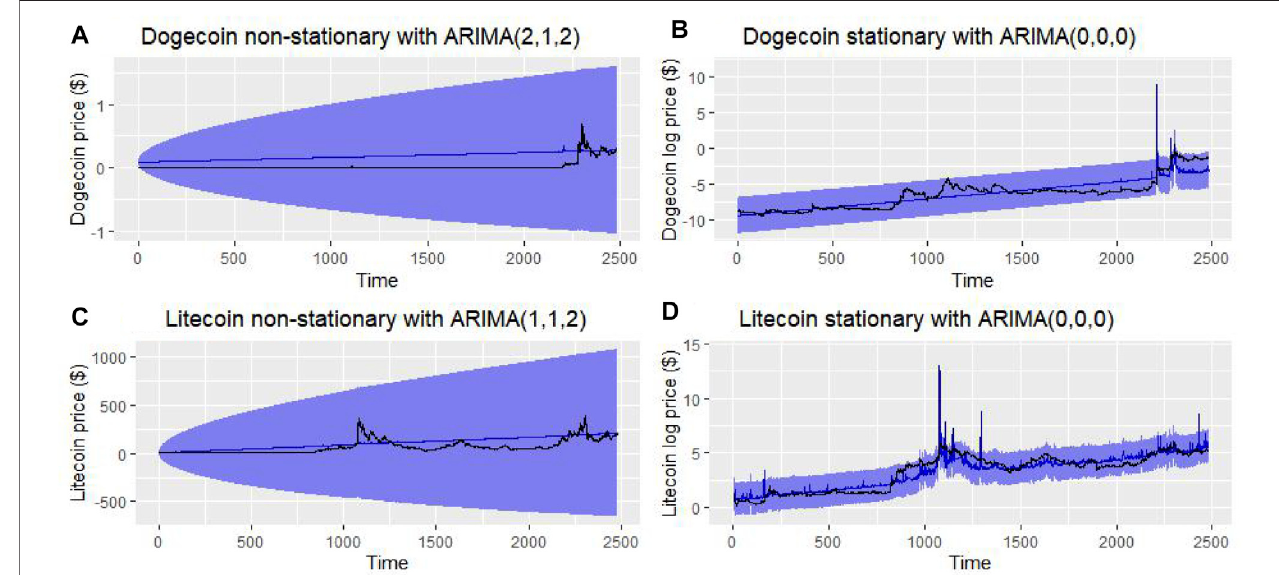
FIGURE 9 | Past price